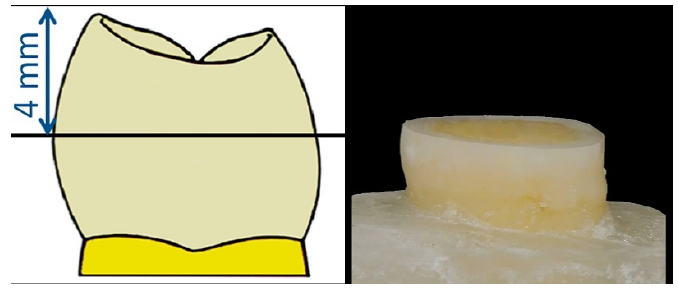
Figure 1. crowns cut parallel at 4 mm from the occlusal plan. Figure 1. Crowns cut parallel at 4 mm from the occlusal